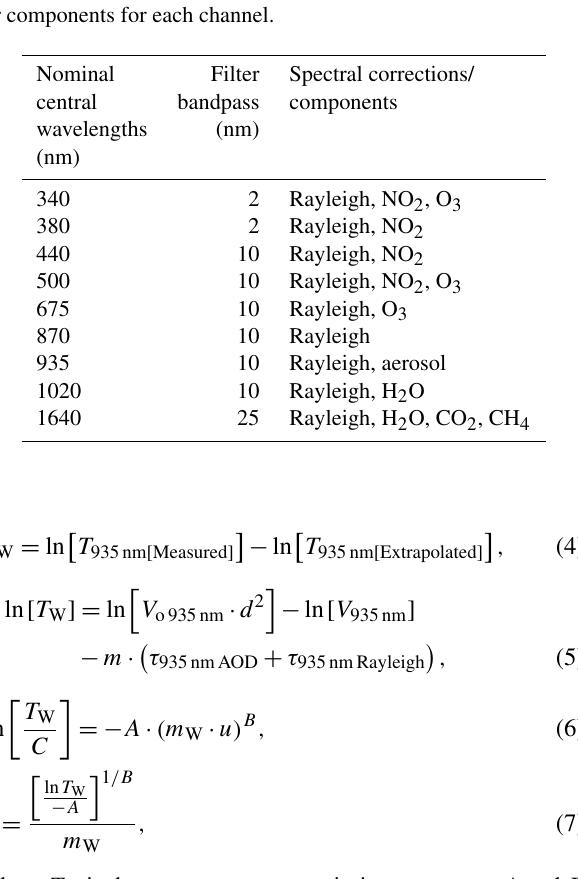
Table 1. Nominal AERONET wavelengths for ion-assisted deposi- tion filters used for aerosol remote sensing and spectral corrections or components for each